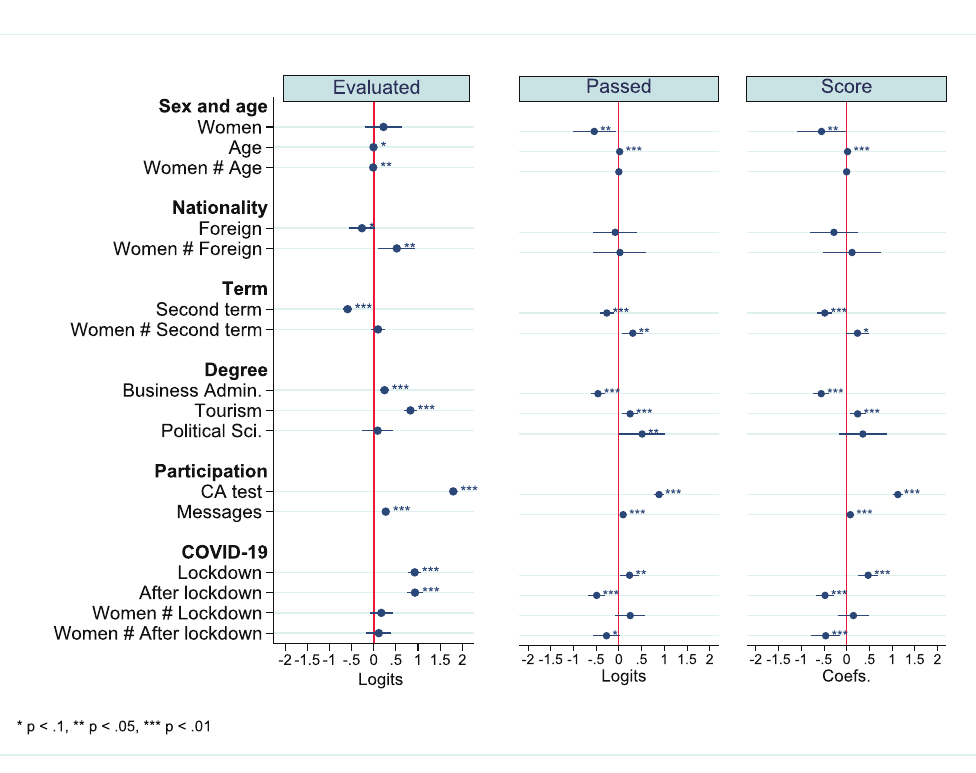
Fig 1. Graphical representation of the whole model with interaction estimation results.